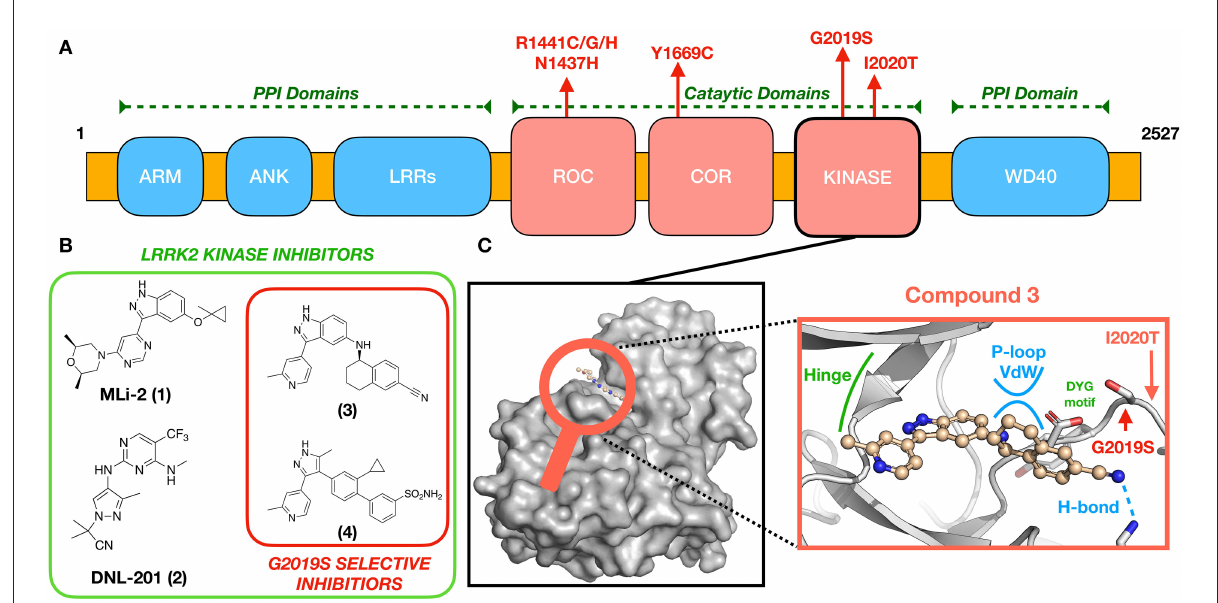
FIGURE1 (A) LRRK2 domain organization and location of pathogenic mutations. (B) Chemical structures of some known brain-penetrant LRRK2 kinase inhibitors, including G2019S-selective compounds. (C) An expanded view (center) of (3) docked to a GS-LRRK2 kinase active site homology model (8), including locations of the known pathogenic mutations G2019S and I2020T. Compound 3 is proposed to interact uniquely with G2019S-LRRK2 through glycine-rich P-loop Van der Waals (vdw) and hydrogen bonding